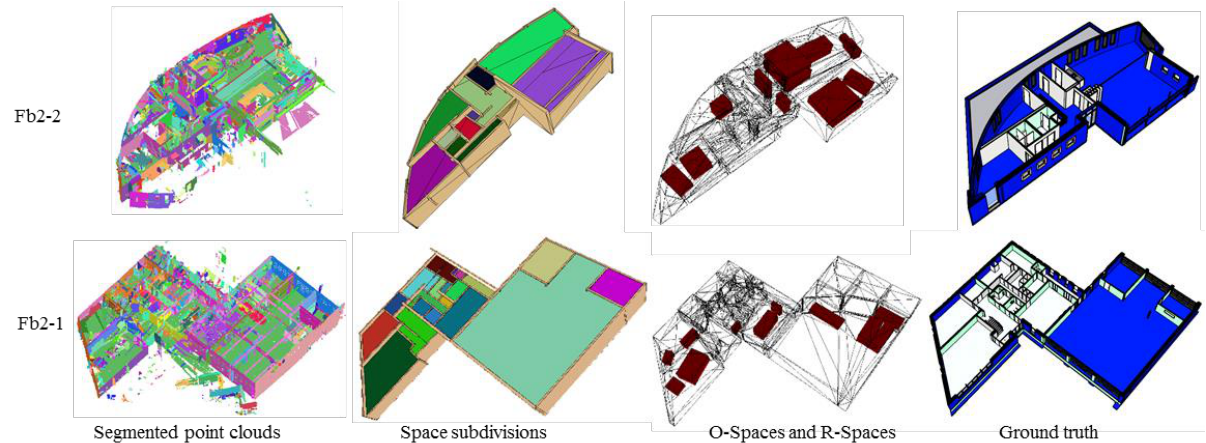
Figure 8 : The result from Fb2 dataset. For each floor in order, we represent the segmented point clouds, the space subdivisions with walls, the occupied spaces (red boxes) and the remaining spaces (R-spaces in white) and finally the ground truth. The first row is the second floor of the Fb2